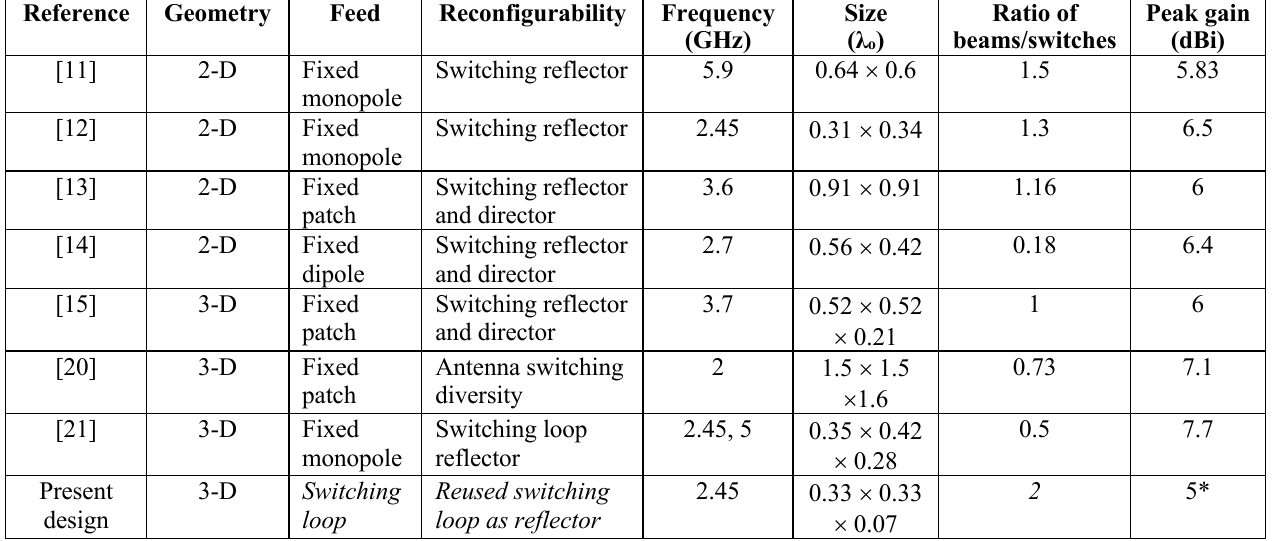
Table 2: Comparison of the proposed design with published reconfigurable antennas